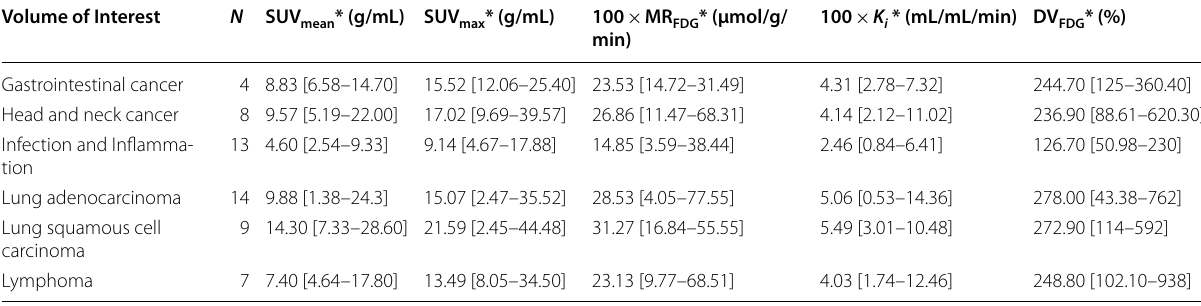
Table 3 Values from pathological findings ( N